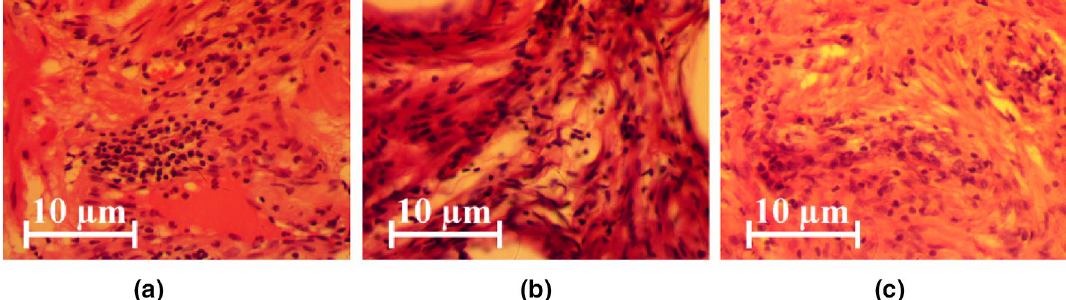
Figure 1. Representative real colour microscopic images (magnification ×50, biological microscope Ulab XY-B2T LED, digital camera UCMOSS08000KPB) of: ( a ) a prostate adenoma sample, ( b ) a moderately differentiated (3 + 3) prostate carcinoma sample, and ( c ) a poorly differentiated (4 + 4) prostate carcinoma